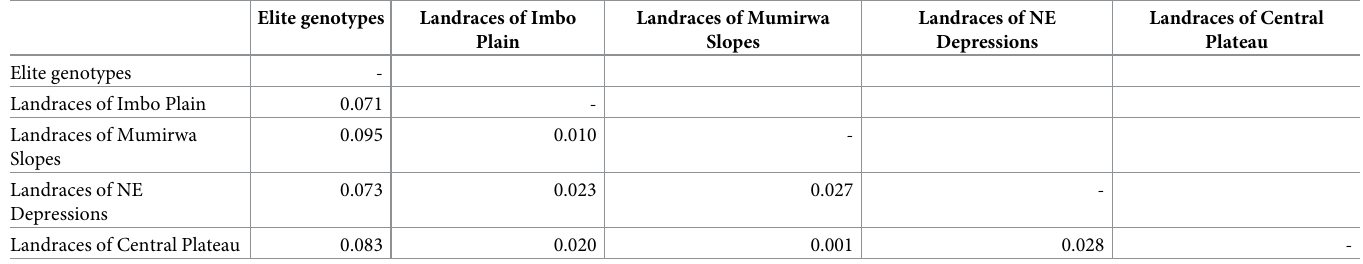
Table 4. Pairwise fixation index between landraces from different